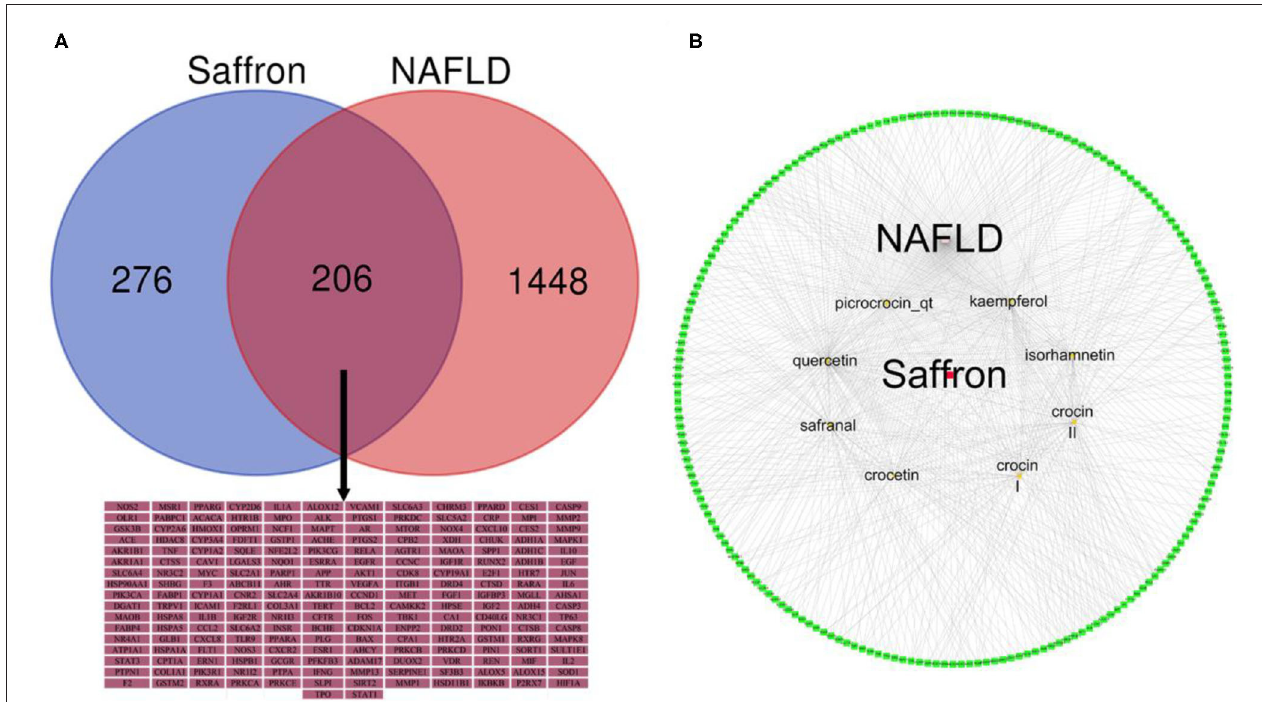
FIGURE 3 | (A) Venn diagram of the targets of Saffron in NAFLD. (B) A network of bioactive ingredients and NAFLD-related targets. The red node represent saffron and the eight yellow nodes represent the bioactive ingredients in saffron; the green nodes represent common targets of the bioactive ingredients of saffron and NAFLD-related. The edges denote that nodes can interact with each